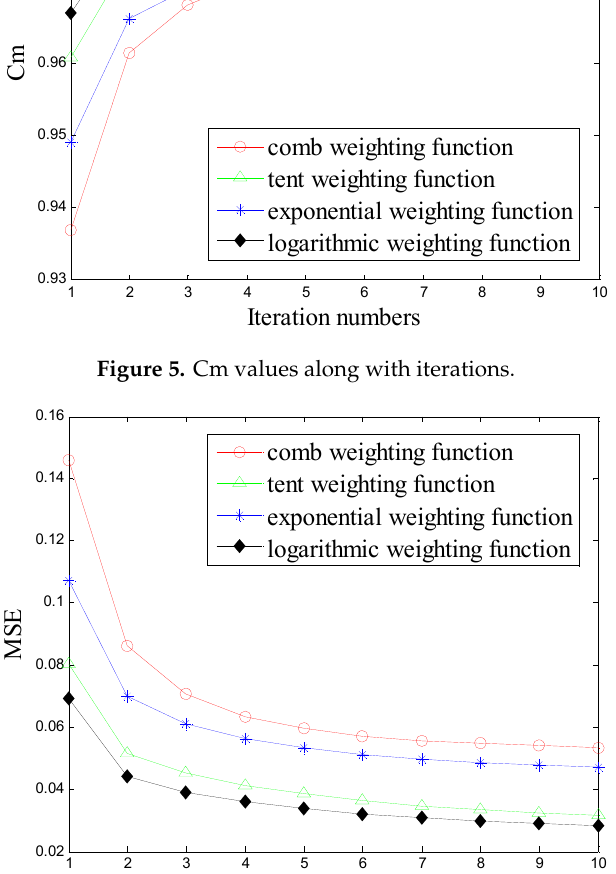
Figure 6. MSE values along with iterations.